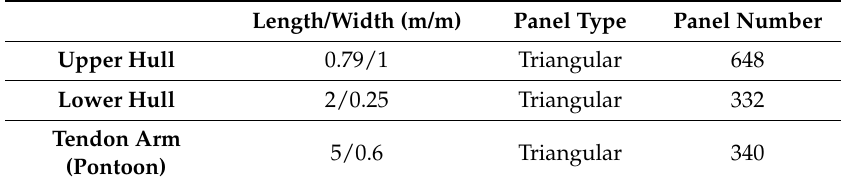
Figure 13. The mesh discretization of the UMaine TLP with triangular panels. (Unit: m.) Table 4. Panel properties of the UMaine TLP wetted hull.